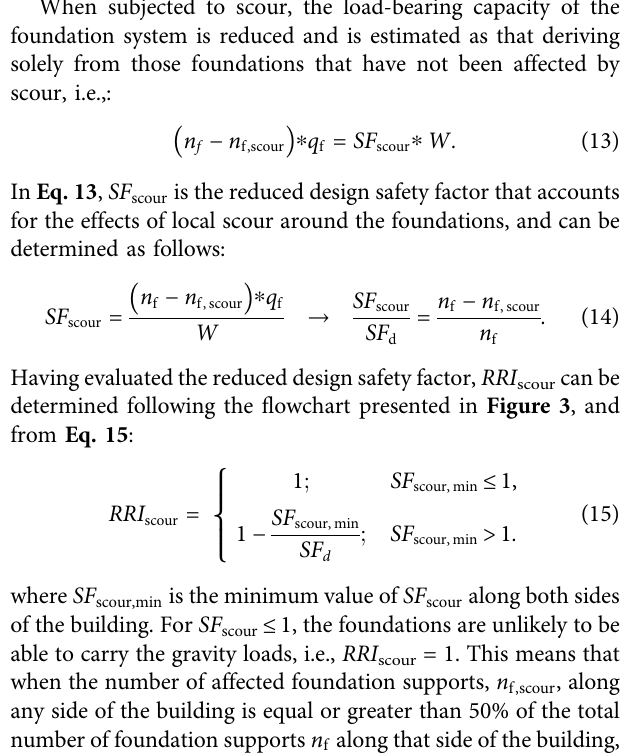
Frontiers in Earth Science |